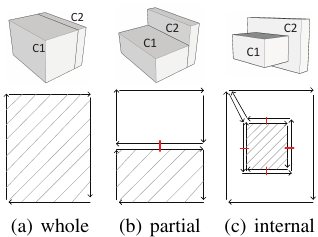
Figure 8. Mapping categories from the connection geometry to a 2-cell Figure 9 illustrates the procedure of sewing two 3-cells by a connection curve. The first step is determining the segments of the boundary of an extrusive profile, which overlaps or intersects with a connection curve. The next step is determining the SIDE 2-cells whose external boundaries share the segments. Next, the procedure determines whether to split the 2-cell vertically. If the curve does not cover the overall segment, the 2-cell should be split into two or three 2-cells.